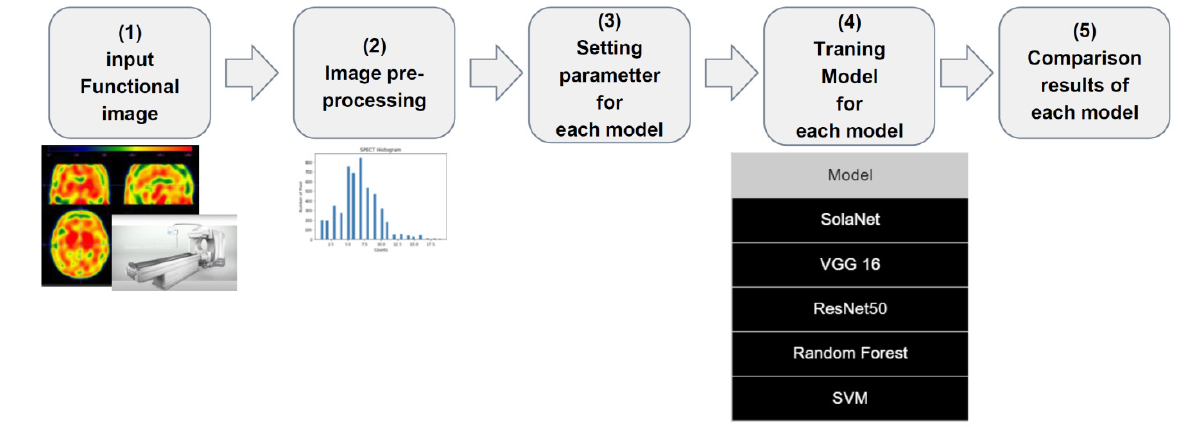
Figure 2. Flow of the application of our small convolutional neural network, which has a low number of parameters, to functional imaging.